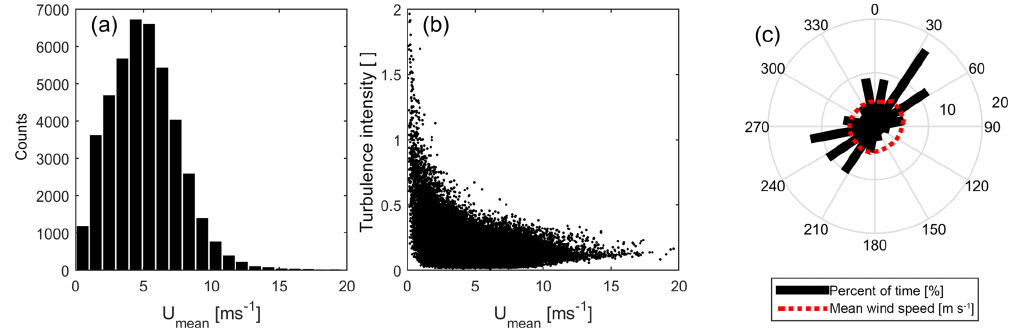
Figure 2. Overview of wind conditions at Perdigão. (a) The 10min mean wind speed distribution at 60ma.g.l. on Tower 29. (b) The 10min turbulence intensities versus mean wind speed at 60ma.g.l. on Tower 29. (c) Wind rose (black bars) and mean wind speed (red dotted line) from data collected at 60m a.g.l. on Tower